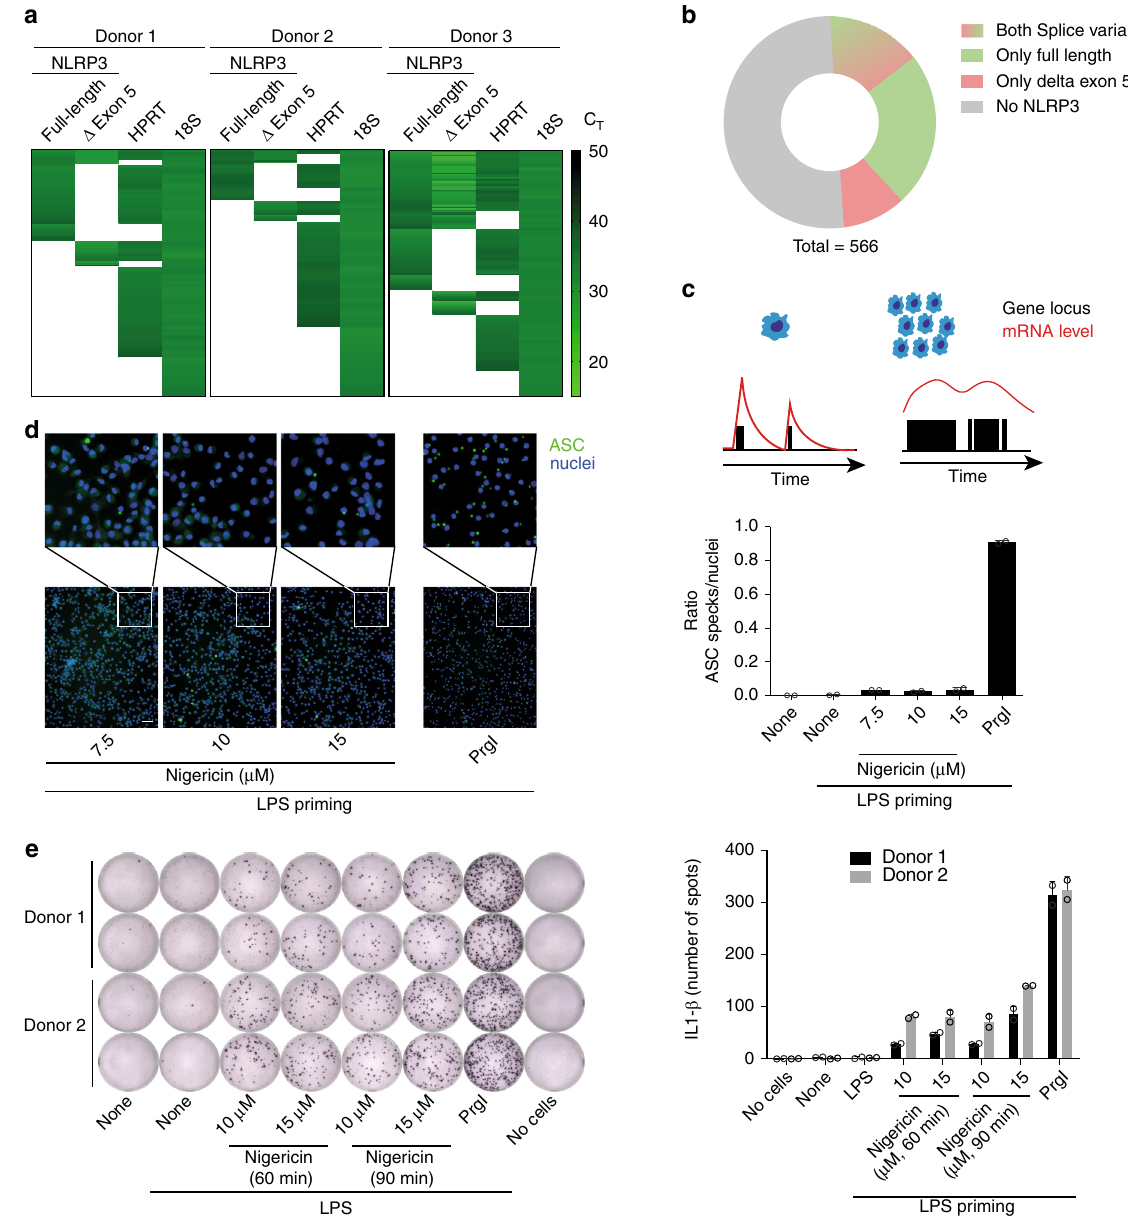
Fig. 5 NLRP3 splicing is regulated on a single cell level. a Single PI-negative GM-CSF derived hMDMs were FACS-sorted into individual wells and lysed. RNA was reverse transcribed and NLRP3 full-length, NLRP3 Δ exon 5 and HPRT encoding mRNAs were pre-ampli fi ed. Transcripts were detected with nested TaqMan assays. 187 to 192 individual cells per donor. b Quanti fi cation of the single cell NLRP3 splice pattern. Shown as the mean of three donors from a . c Scheme of the burst-kinetic of gene-expressions on single-cell level, resulting in oscillations of produced mRNA levels per gene. d Human monocyte-derived macrophages were analyzed for ASC speck formation by fl uorescence microscopy after NLRP3 activation with nigericin and NLRC4 activation with bacterial product PrgI (both 1.5 h). Cell nuclei were counterstained with Draq5. Scale bar represents 50 μ m. Five images per well were captured, plotted are means and SD of two replicate wells, representative of four individual experiments. Overlaid symbols represent single measurements. e IL-1 β ELISpot assay of hMDMs after NLRP3 or NLRC4 in fl ammasome activation. Shown are two independent donors. Mean and SD of technical duplicates, two independent donors. Overlaid symbols represent single measurements. See also Supplementary Fig. 5. Source data are provided as